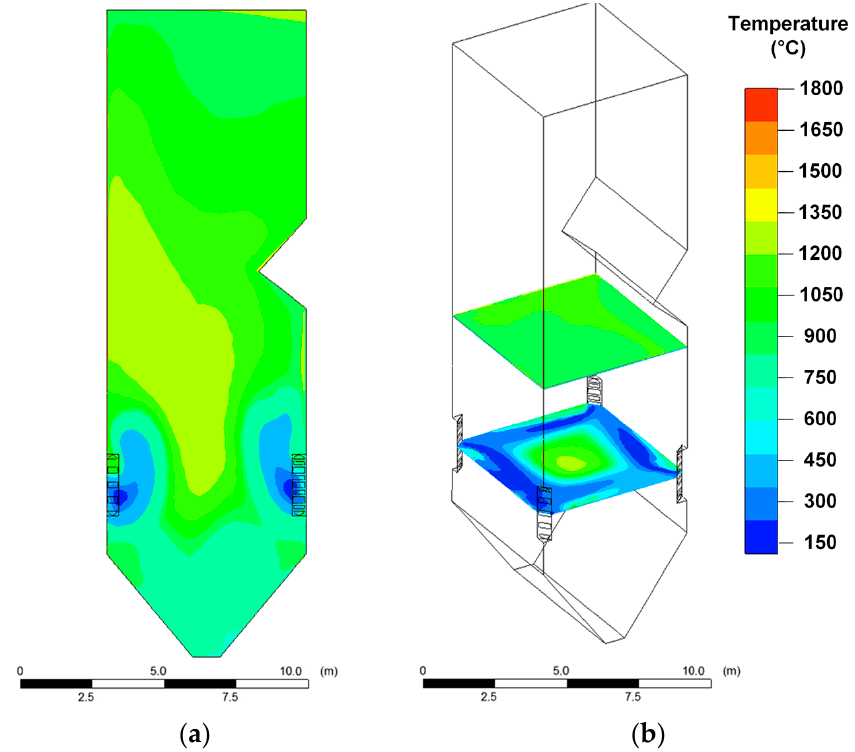
Figure 4. Typical temperature fields in the boiler furnace when burning CWS: in the longitudinal section ( a ); in the cross sections ( b ).